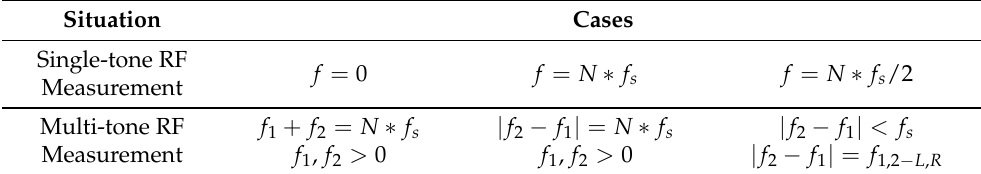
Table 2. The cases of frequency ambiguity in the proposed